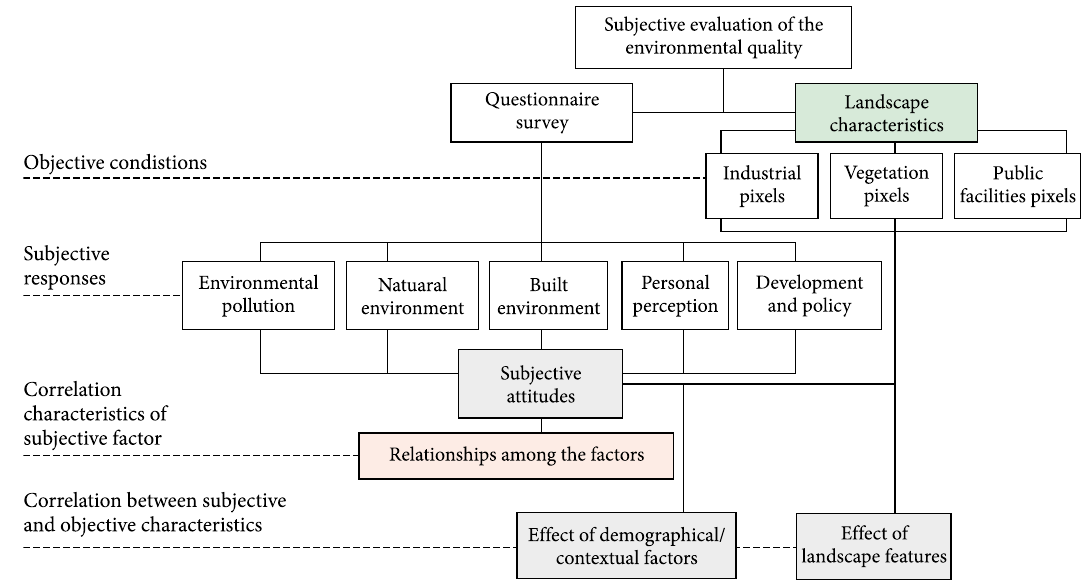
Fig. 5. The framework of the subjective evaluation of the environmental quality of industrial